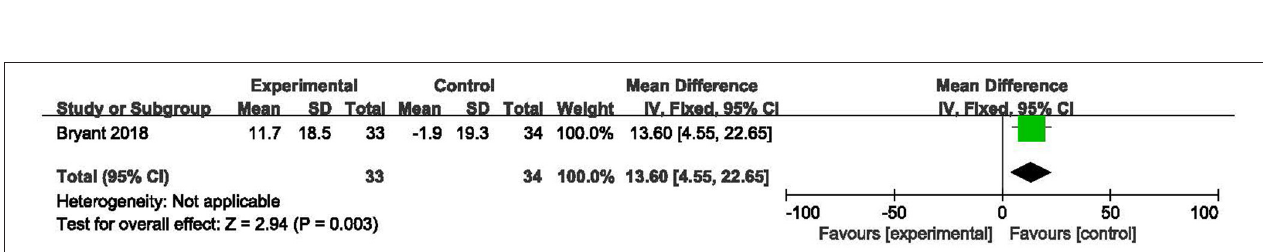
Frontiers in Psychiatry |